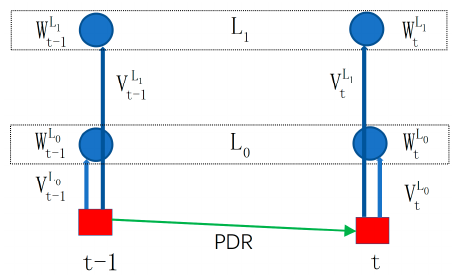
Figure 4. Coupled PDR and WiFi for any two adjacent moments. The left and right red rectangle represent the coordinate x pre ,y pre and x post ,y post in Equation (9), respectively, the circle labelled with W L i represents the received WiFi with the error level L i at j, the upward line segment labelled with V L i represents the coupled vector by Equation (9), the green segment represents the time update of the scheme via